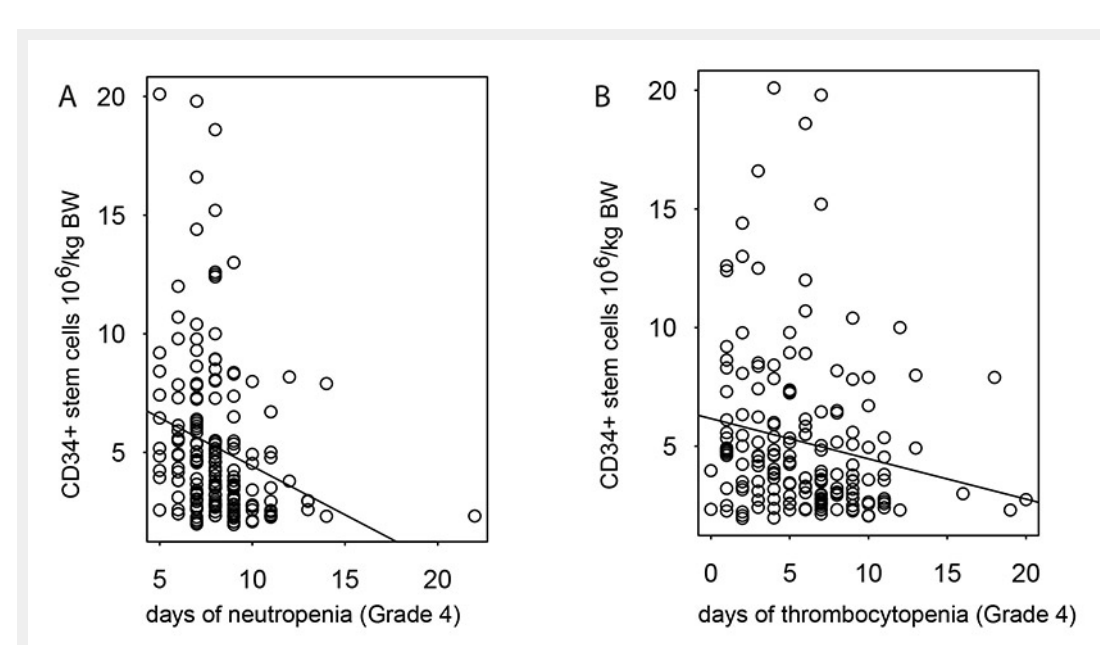
Figure 1 Correlation of the number of reinfused CD34+ stem cells with the length of neutropenias (r = –0.25, fig. A) and thrombocytopenias (r = –0.18, fig. B) after